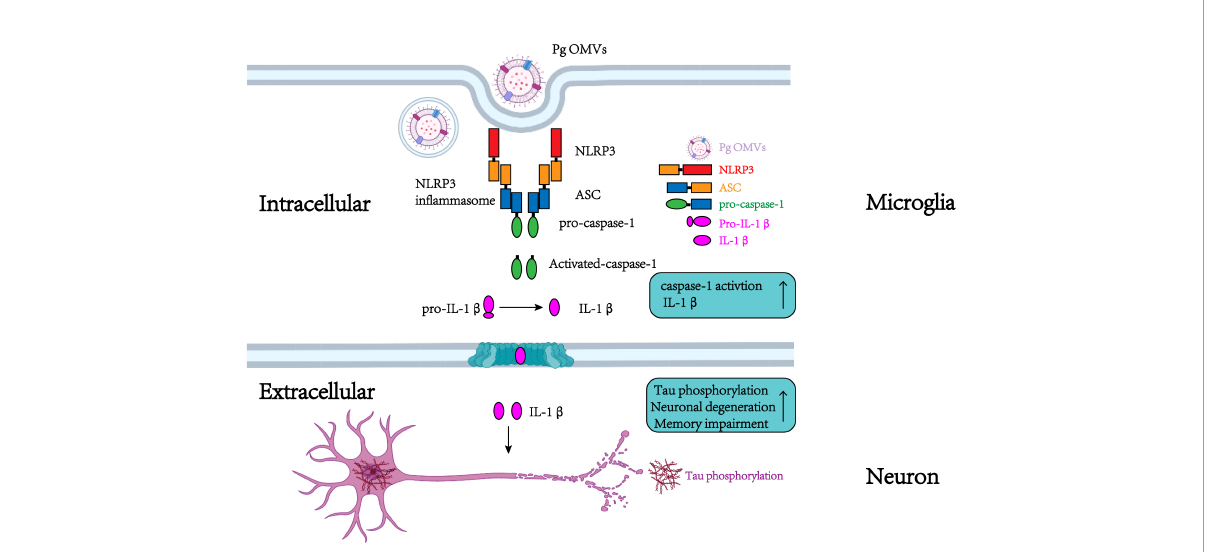
FIGURE 11 Schematic to show the roles of Pg OMVs on microglia and neurons. In microglia, Pg OMV induce IL-1 b production though the activation of the NLRP3 in fl ammasome. In neurons, the microglia-released IL-1 b is involved in tau phosphorylation, neuronal degeneration, and memory impairment. Created with